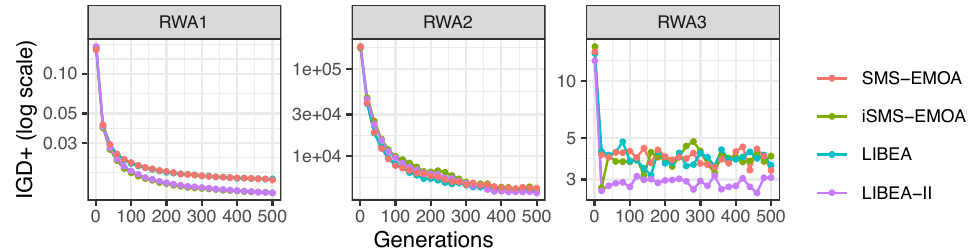
Figure 4. Convergence of the IGD + quality indicator on the three real-world